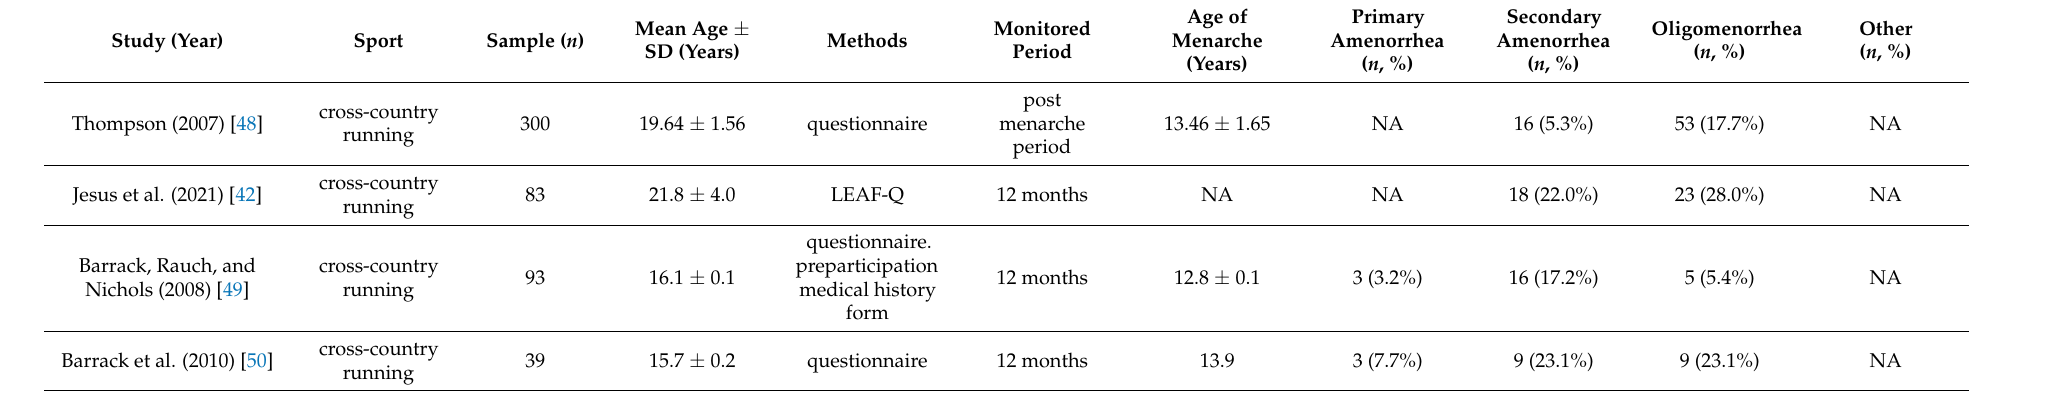
Table 3. Sample characteristics, menstrual disorders measurement and prevalence in cyclic